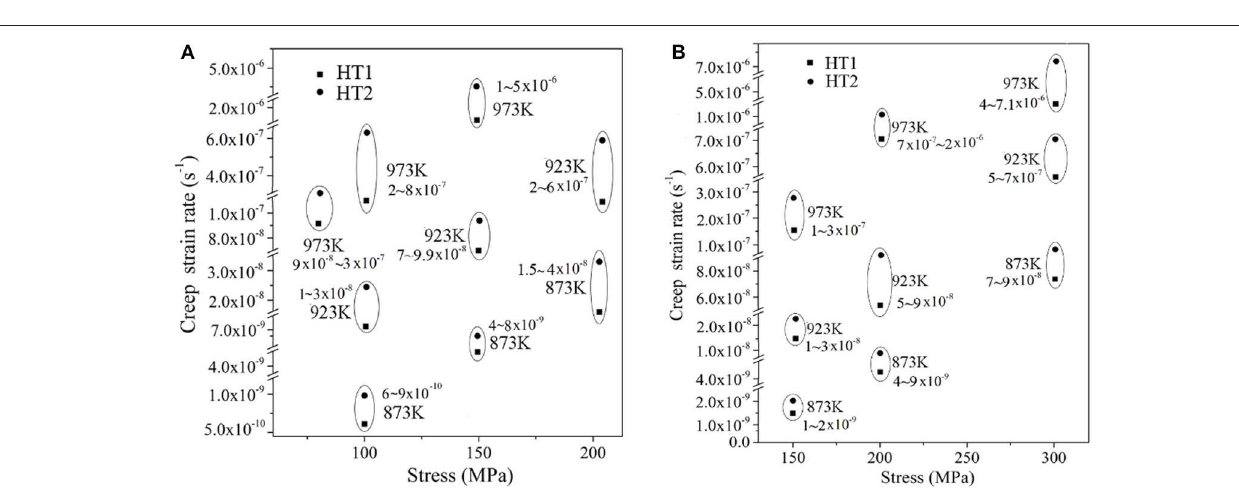
FIGURE 7 | Creep strain rate of specimen after heat treatment. (A) Matrix alloy. (B) TMCs.